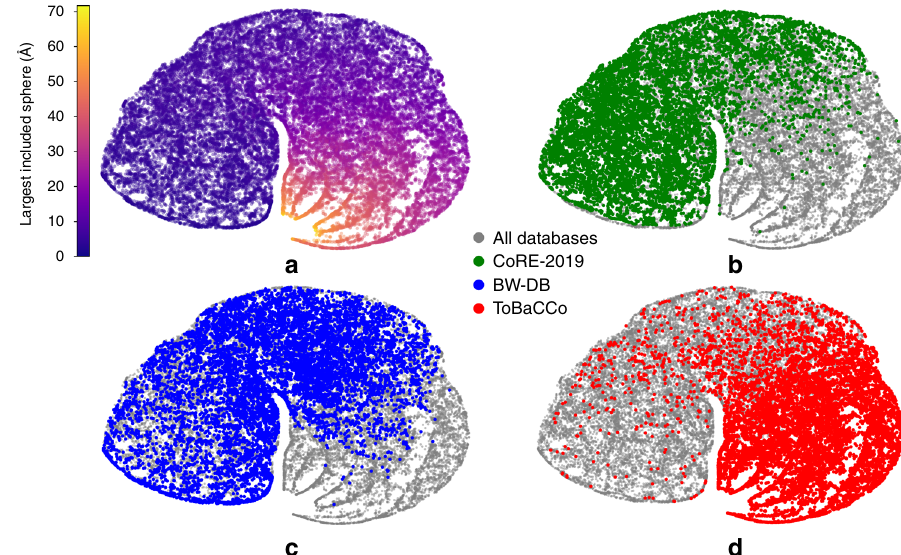
Fig. 2 Map of the pore geometry of MOFs. To project the geometric descriptor space of MOFs to a 2D map we use the t-distributed stochastic neighbour embedding (t-SNE) 67 method (see Supplementary Note 6 for principal component analysis (PCA)). The t-SNE method preserves local similarity, ensuring similar structures are mapped close to each other in two dimensions. a The current design space colour coded with the largest included sphere. In ( b ), ( c ), and ( d ), the green, blue and red dots are representing the materials in the CoRE-2019, BW-DB and ToBaCCo databases, respectively, which are overlaid on the design space represented in grey. PCA plots show a similar distribution of databases (see Supplementary Note